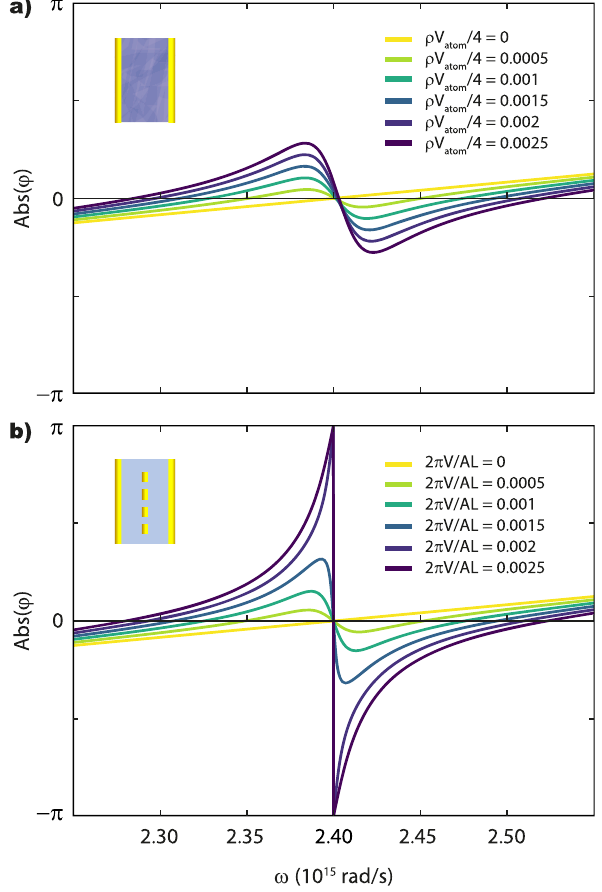
Figure 9: The argument φ when viewing the resonant denominator of Eq. (22) as − 1 + Ae i φ as function of frequency, and at the etalon opening where the bare etalon has its resonance frequency at the resonance ω 0 (cid:1) 2 . 4 ⋅ 10 15 s − 1 of the inserted species. According to Ref. [39] zero-crossings correspond to the Rabi-split normal mode frequencies. Panel (a) is for a homogeneous atomic gas, and panel (b) for a dispersive metasurface. Different line colors vary oscillator strength and density in linear increments. Note how the zero crossings move away from ω 0 in proportion to the square root of the oscillator strength. Finally, we have taken oscillator strengths that correspond to identical location of the zero crossing in (a) and (b). Nonetheless, the phase variation for frequencies between the crossings is strongly different. Parameters as in Figure 8, with oscillator strength V varied as indicated in the legend.